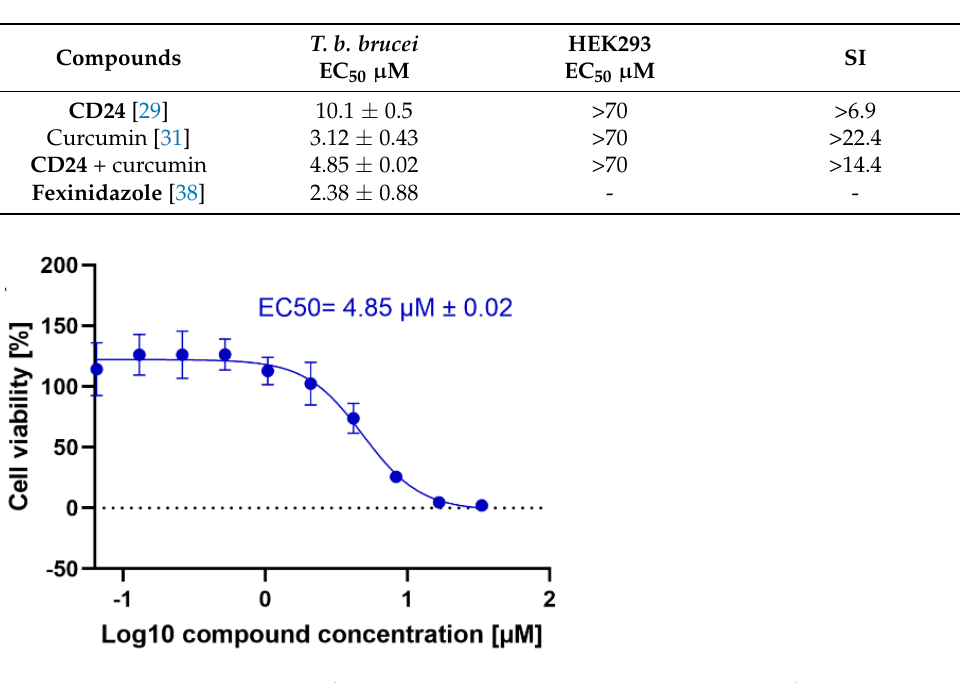
Figure 5. Dose–response curves of the combination CD24 + curcumin against T. b. Brucei. A classic isobologram analysis was performed to evaluate which of the used doses of CD24 and curcumin, used in a molar ratio 1:1, was able to produce a synergistic effect when combined against T. b. brucei (Figure 6). If the combination data points fell on the hypothenuse (i.e., the dose of 16.66 µ M), an additive effect was indicated. If the combination data points fell on the lower left (e.g., all the doses ranging from 0.06 µ M to 8.33 µ M) a synergism was indicated. While for the sole combination point that fell on the upper right (i.e., 33.33 µ M), an antagonistic effect was indicated.